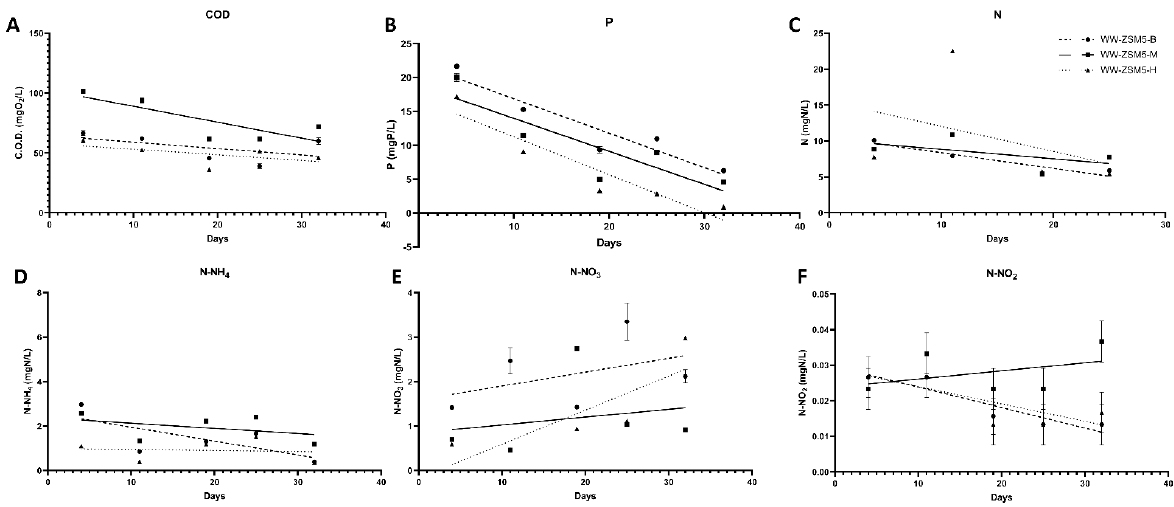
Figure 5. Variation of physicochemical parameters during WWT experiment using 3D-printed ZSM-5 biocarriers. ( A ) COD, ( B ) P, ( C ) N, ( D ) N-NH 4 , ( E ) N-NO 3 , ( F ) N-NO 2 . Plotting the 3D-printed biocarriers that stood out, together with the WW-SPHERE and the WW-CONTROL, we noticed that WW-ZSM5-H contributes equally with the WW-SPHERE in the WWT and is better than the control. Interestingly, N-NH 4 decreased noticeably in all reactors with biocarriers (Figure 6). Regarding the pH values, there was a slight drop in all reactors except the reactor with WW-ZSM5-M (data not shown).